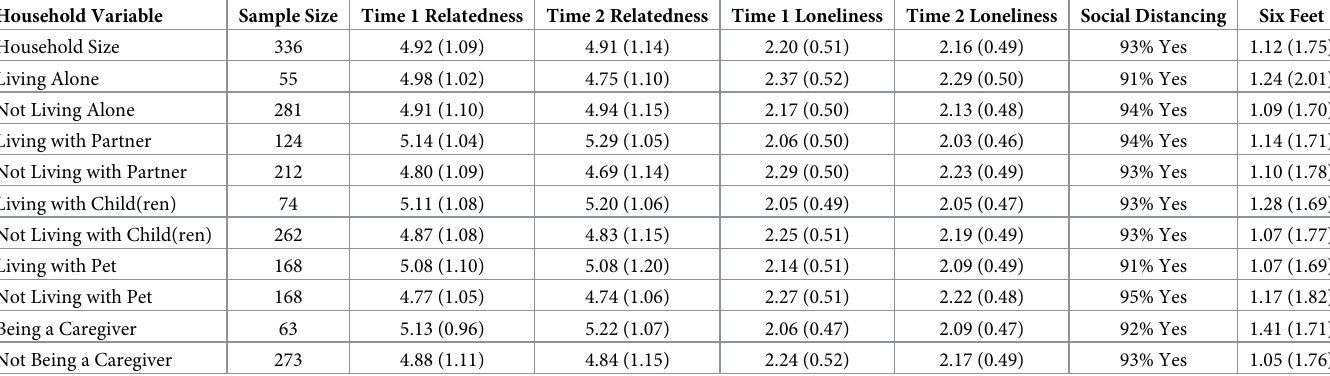
Table 5. Means and standard deviations for household size and composition (Study